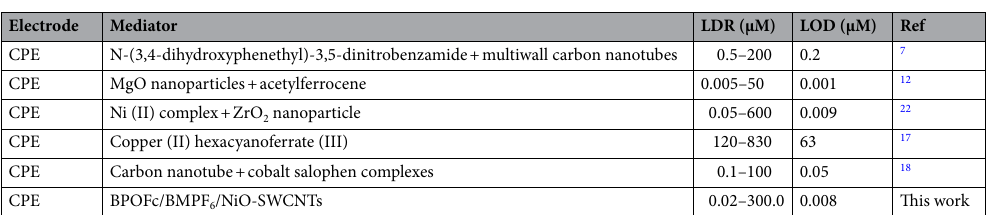
Table 1. Analytical parameters of suggested sensors for determination of N -acetylcysteine.